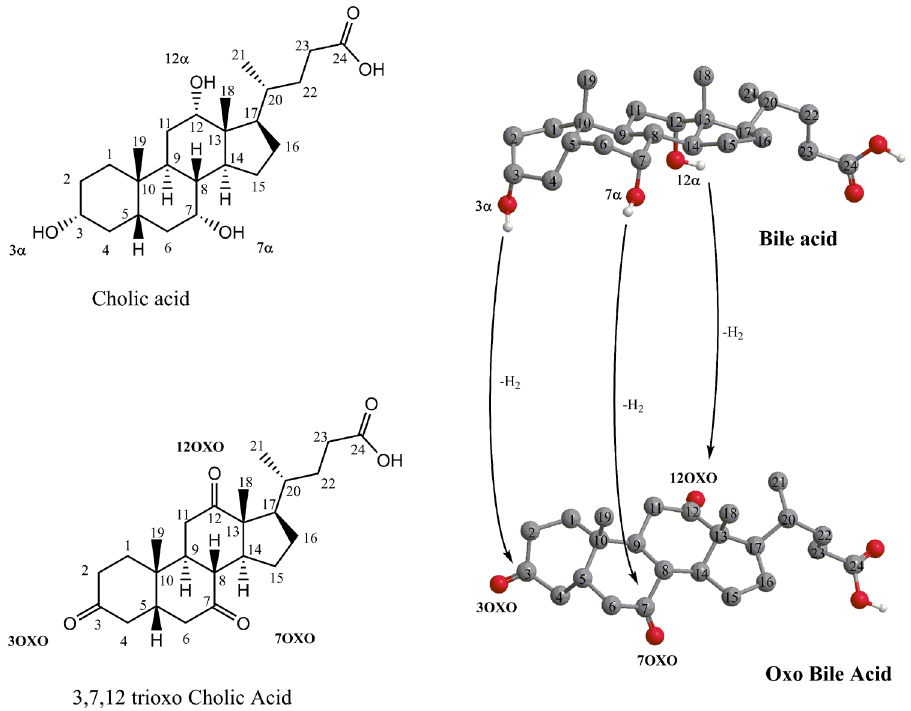
Figure 1. Cholic acid and one of its potential metabolic derivatives, (5β)-3,7,12-trioxocholan-24-oic acid, are produced by microbiota